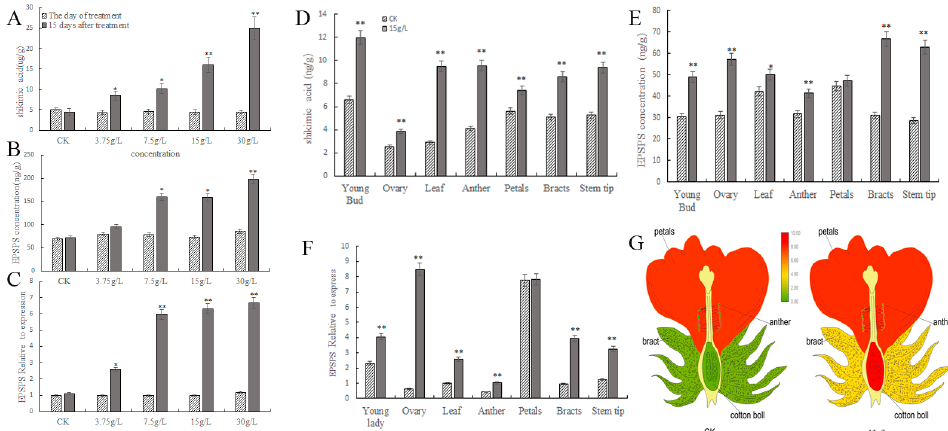
Figure 2. The effect of glyphosate on the shikimic acid content, EPSPS concentration, and EPSPS gene expression in different tissues. ( A ) Shikimic acid content in the leaves after treatment with different concentrations of glyphosate. * indicates a significance level of p < 0.05, ** indicates an extremely significant level of p < 0.01; ( B ) EPSPS synthase concentration in the leaves after treatment with different concentrations of glyphosate; ( C ) the expression levels of the EPSPS gene in the leaves after treatment with different concentrations of glyphosate; ( D ) shikimic acid concentration in different tissues after treatment with 15 g/L glyphosate; ( E ) EPSPS synthase concentration in different tissues after treatment with 15 g/L glyphosate; ( F ) differential expression of the EPSPS genes in different tissues after treatment with 15 g/L; ( G ) expression heatmap of the EPSPS gene in different tissues after treatment with 15 g/L glyphosate.